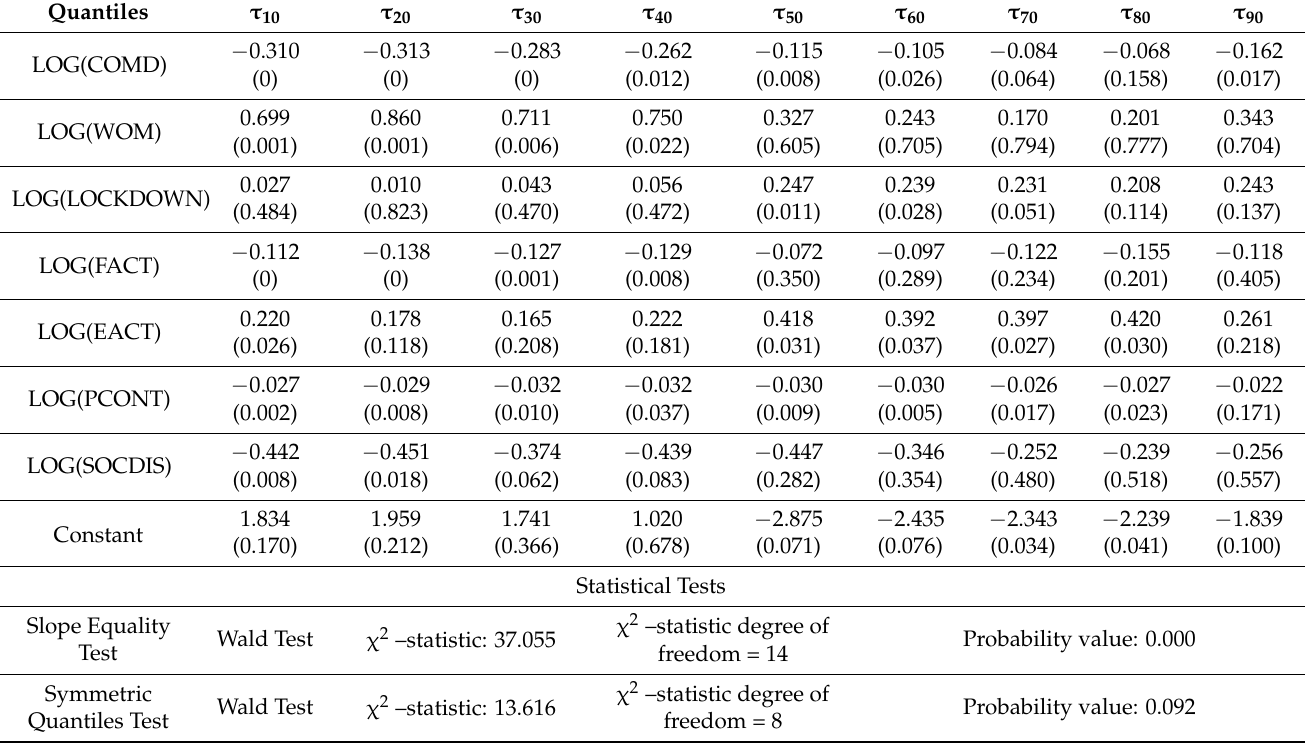
Table 5. Quantile Regression